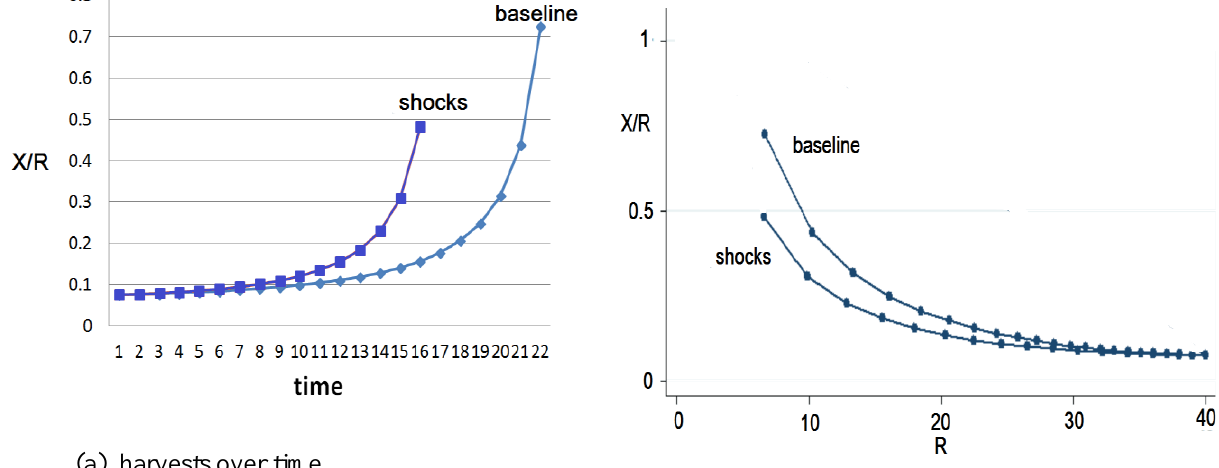
Figure A1.1 The fraction of resources harvested over time. Parameter values used in the figure: K=80, r=0.1, R =45, β=0.99 correspond to parameters used in the experiment. We assume shocks to be equal to the expected 0 value of shocks in the experiment: z =1 in the shock treatment; and z =0 in the t t